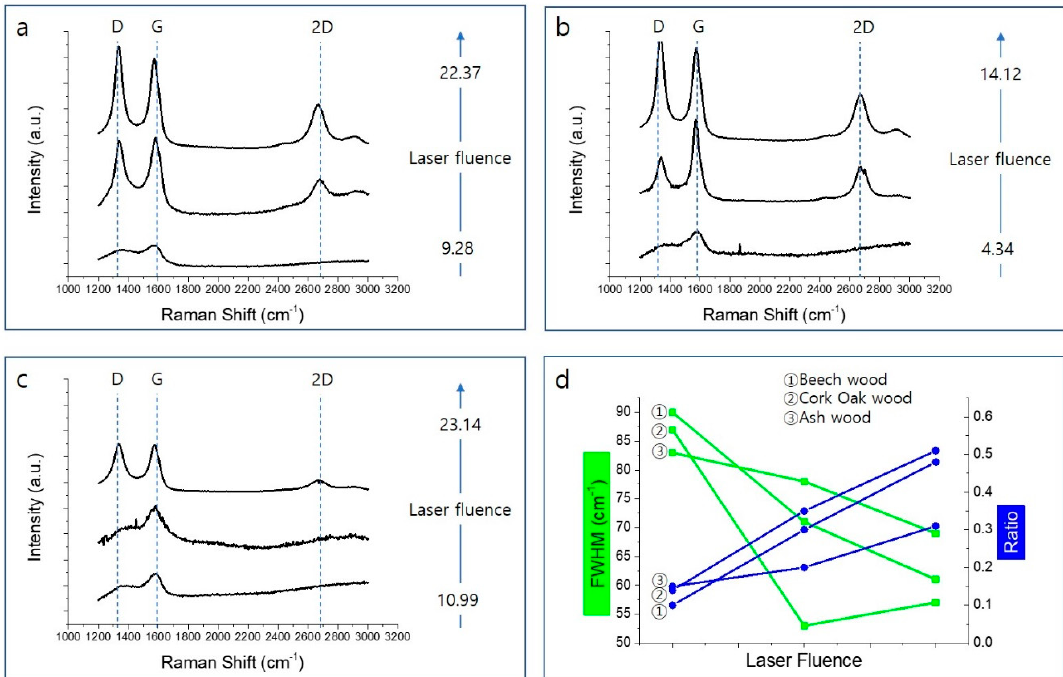
Figure 6. Changes in characteristics of beech, cork oak, and ash wood according to laser fluence; ( a – c ) Raman spectrum of three wood surfaces, ( d ) full-width-at-half-maximum (FWHM) and I 2D /I G ratio of G peak according to laser intensity.